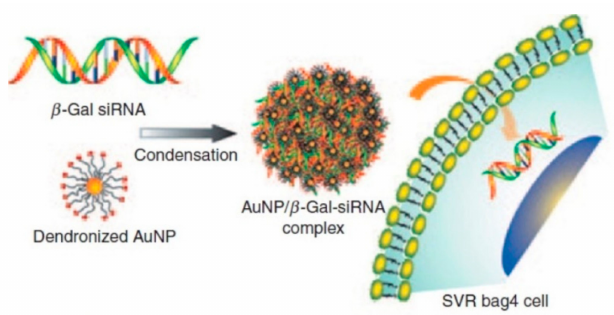
Figure 5. Schematic illustration of G2-AuNP / β -gal-siRNA complexation and transfection into SVR-bag4 cells